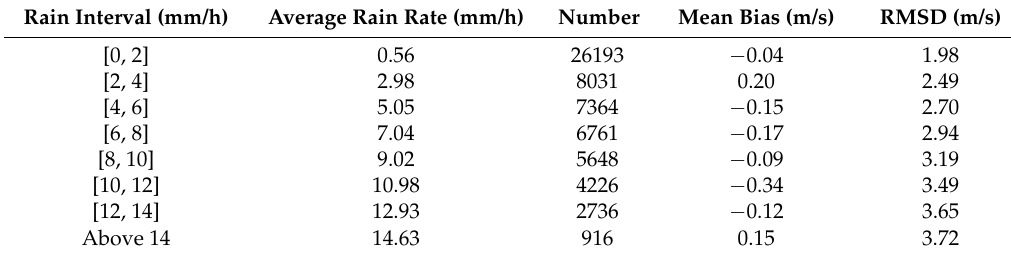
Table 4. Statistics for different rain intervals between H*wind analysis data and the retrieved wind speed using AMSR-E